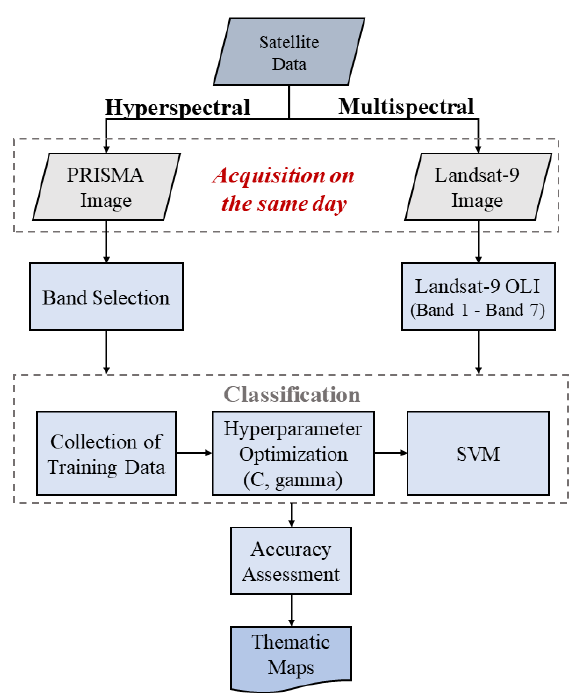
Figure 2. The flow chart of the methodology used. Since, Landsat-9 Level-2 satellite image and PRISMA Level 2D satellite images that have been atmospherically corrected were used, no further atmospheric correction was applied to the satellite images. Some of the spectral bands (1-5, 13-15, 20-21, 35-37, 56-63 of VNIR Bands; 42-49, 168-173 of SWIR Bands) of PRISMA satellite image that included high level of noise were eliminated. The composite image was generated from the selected proper spectral bands and defined as input data at the PRISMA image classification stage. On the other hand, coastal, blue, green, red, near infrared, shortwave infrared 1